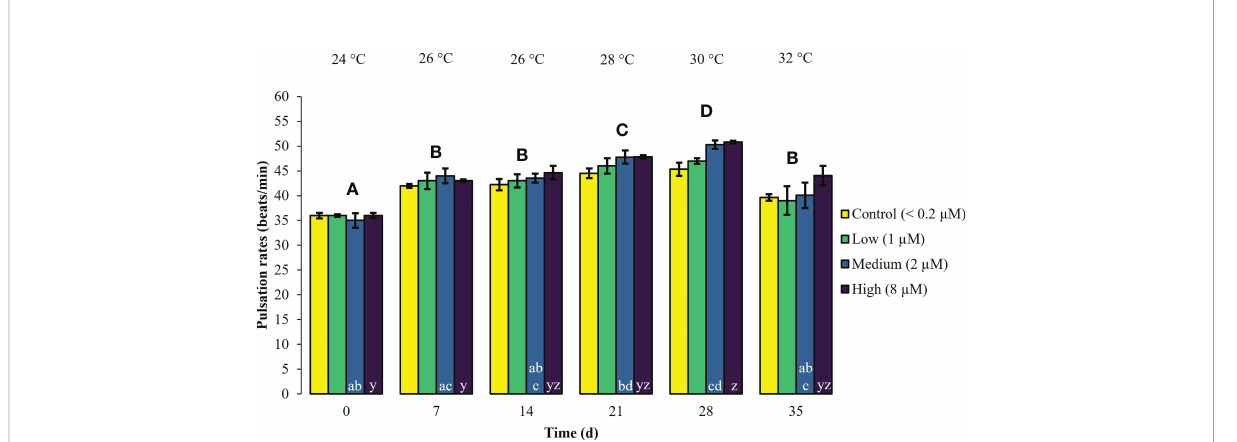
FIGURE 1 Pulsation rates ± SEM of Xenia umbellata colonies (n = 3) kept at different phosphate concentrations (control < 0.2 m M; low ~ 1 m M; medium ~ 2 m m; high ~ 8 m M) and exposed to an arti fi cially induced water temperature increase. Bars represent the mean of three replicates. Different capital letters above bars indicate signi fi cant differences between days and different letters within bars show signi fi cant differences within treatments over time (pwc, Bonferroni adjustment, pairwise t-test, p < 0.05).